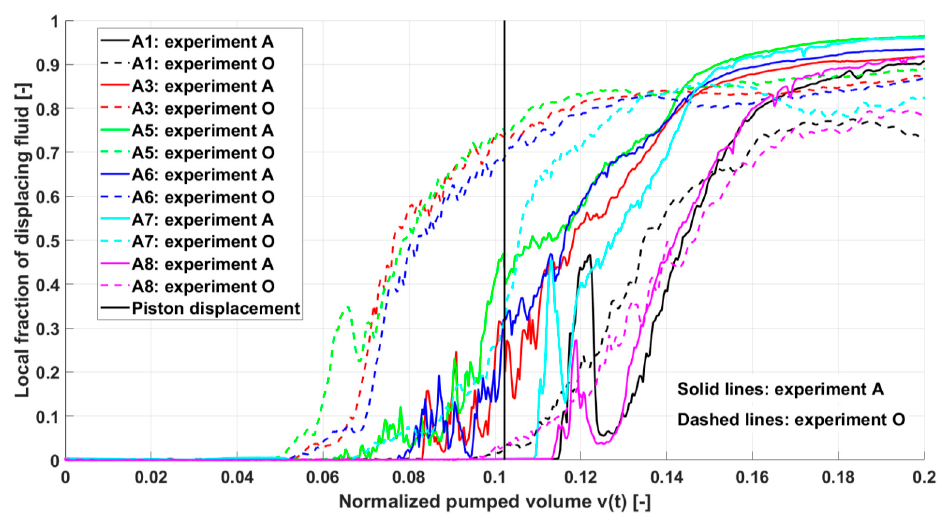
Figure 12. Displacement versus normalized pump volume for equivalent experiments in Experiments A and O. All measurements were conducted at Station A being 2 m from inlet.